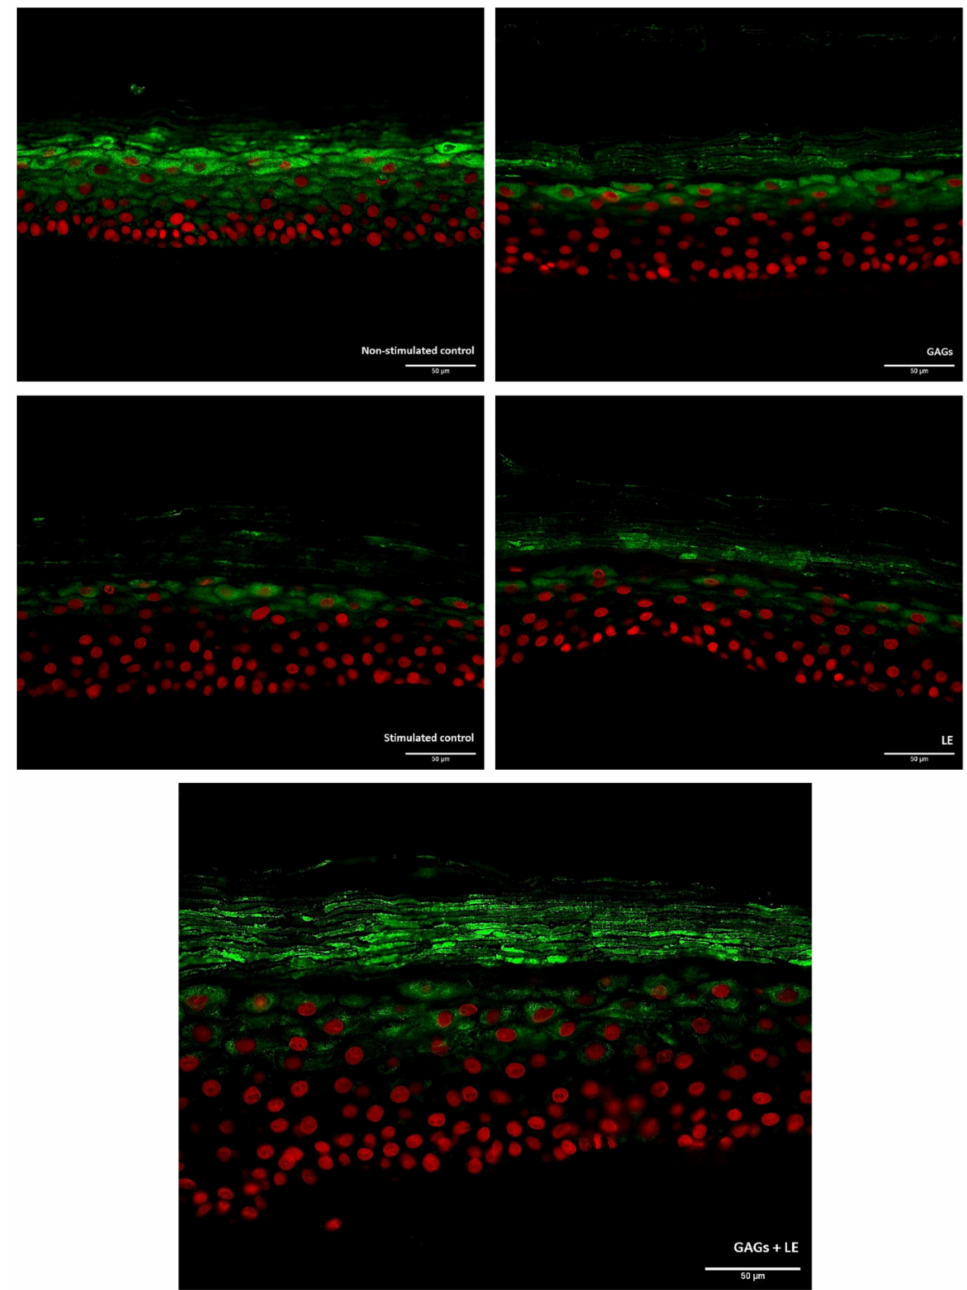
Figure 3. Immunofluorescent staining of filaggrin (green fluorescence) in reconstructed human epidermis (RHE) under cytokine mix (IL-4 + IL-13 + IL-22 + TNF- α at 3 ng/mL each)-stimulated conditions and treated or not (Stimulated Control) with the test compounds (LE and GAGs), alone or in combination, at 0.02 mg/mL each. Scale bar: 50 µ m. Original magnification ×